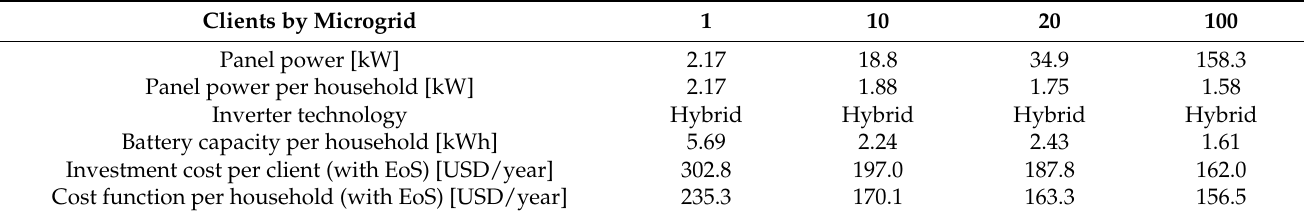
Table 8. Results for microgrids of 1, 10, 20 and 100 residential clients (Case